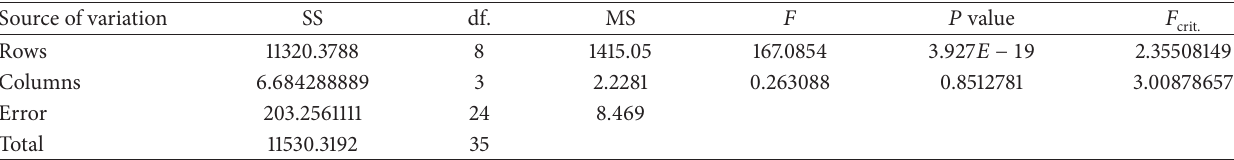
Table 3: ANOVA results of commercial Portland